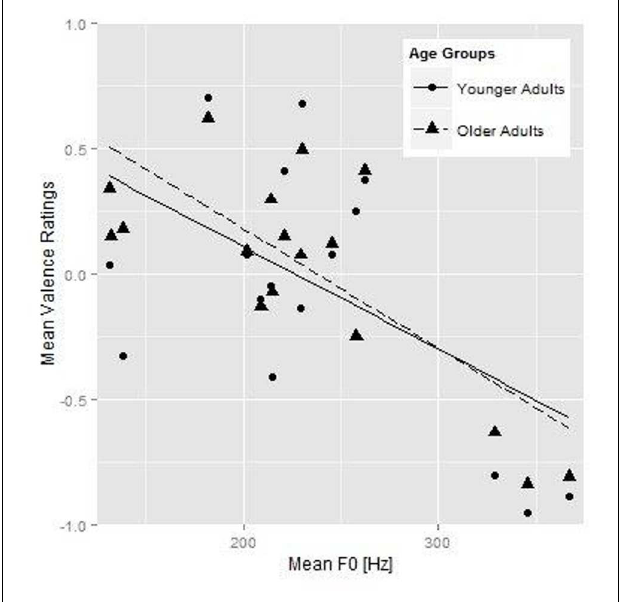
FIGURE 2 | Younger (round symbols) and older participants’ (triangular symbols) mean valence ratings for each individual stimulus as a function of mean F 0 of the speech fragments, and the fit lines for the younger (solid line) and older (dashed line)